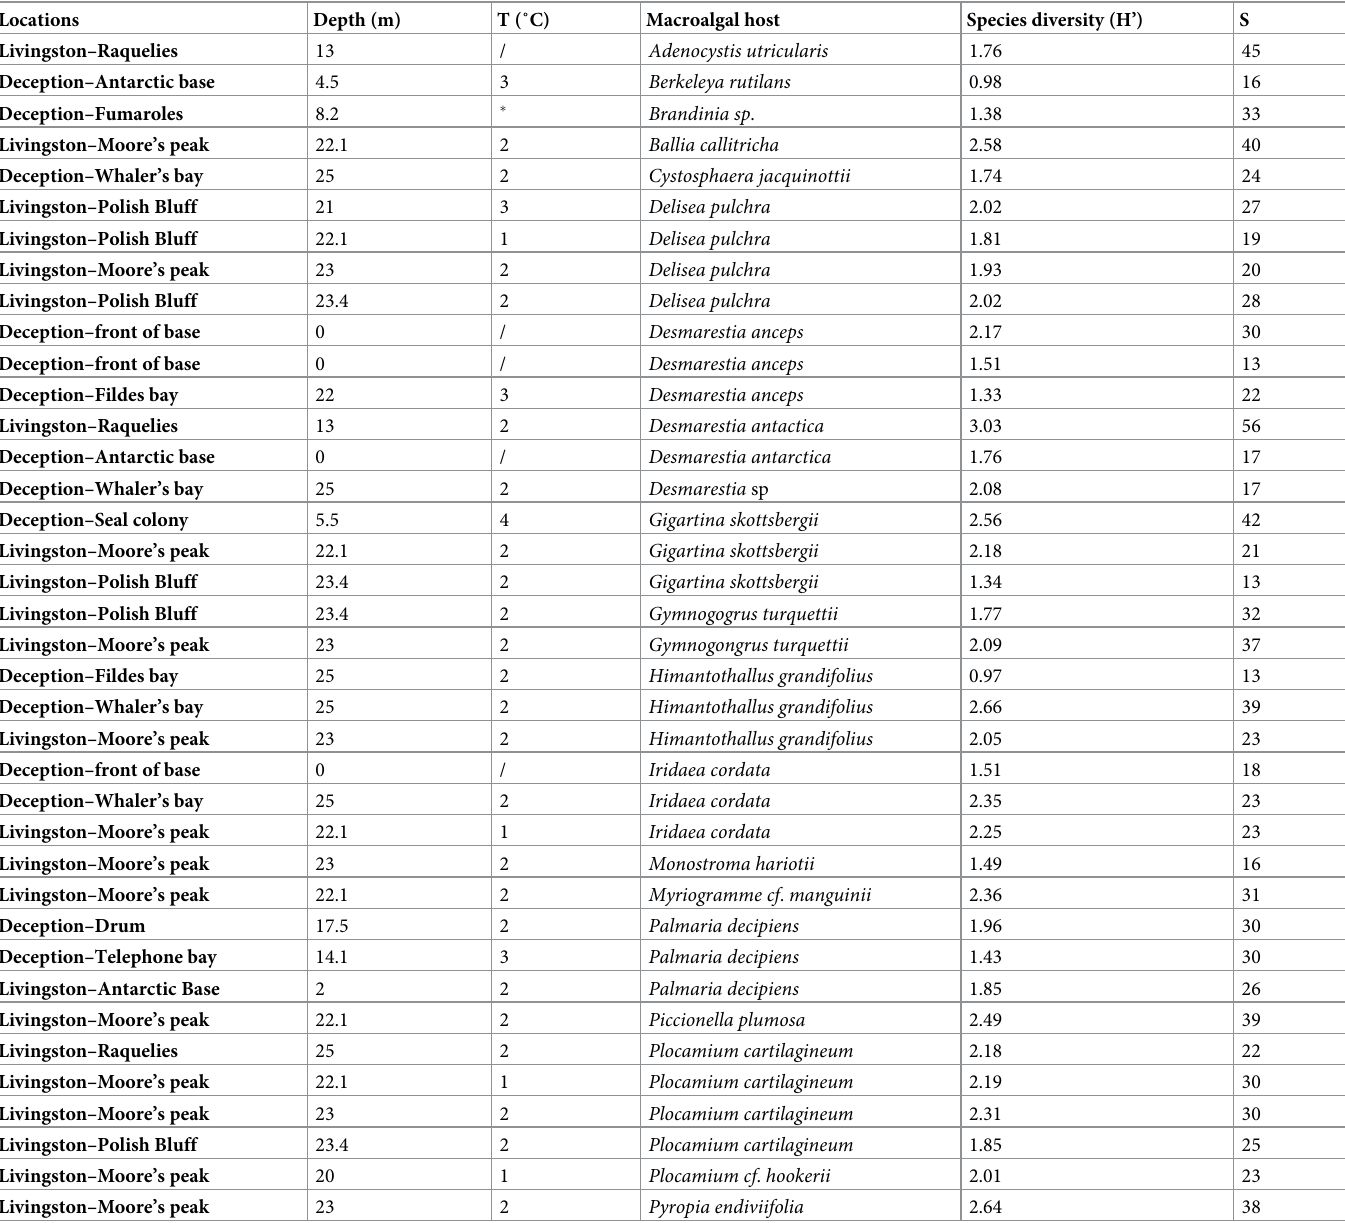
Table 2. Sampling site characterization of depth and temperature (T) and diatom epiphyte richness (S) and diversity (H’) found on each macroalgal host.